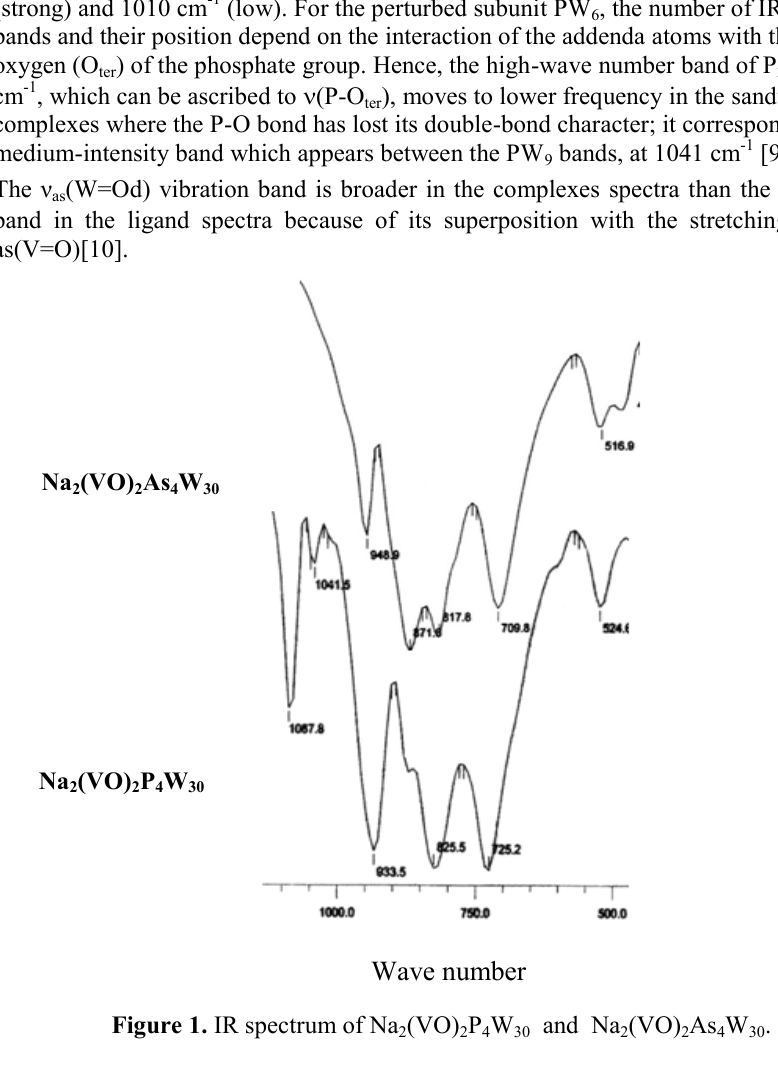
P W and Na 2 4 30